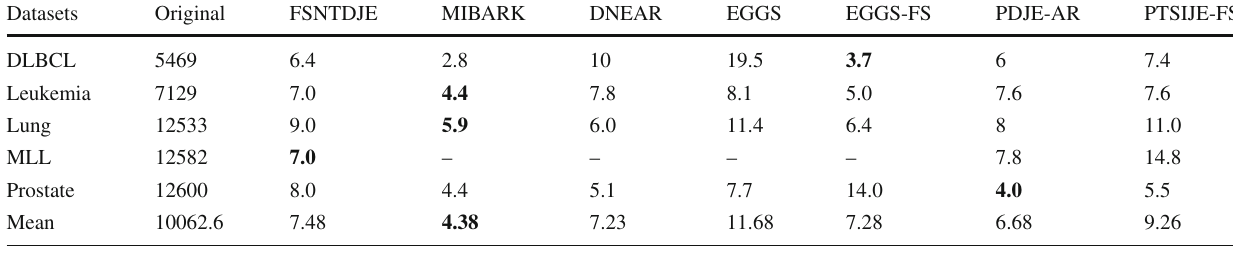
Table 8 Optimal feature subset with PTSIJE-FS for five gene